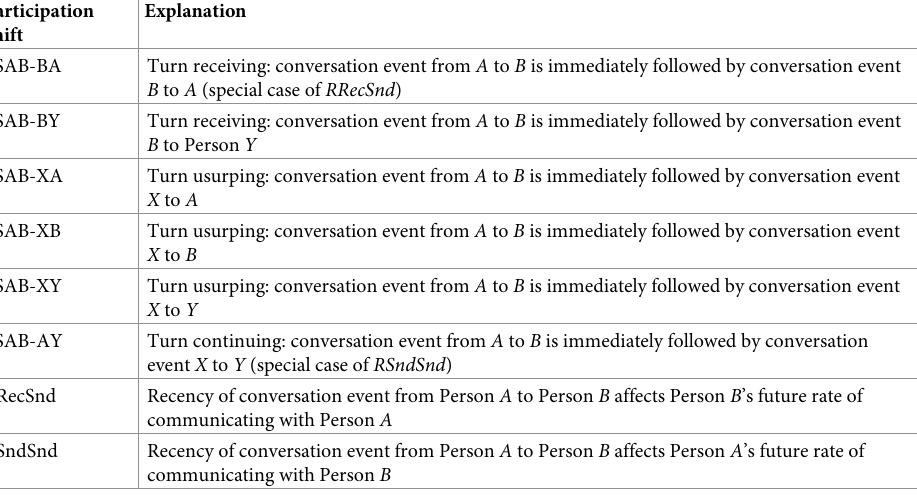
Table 1. Dyadic participation-shifts